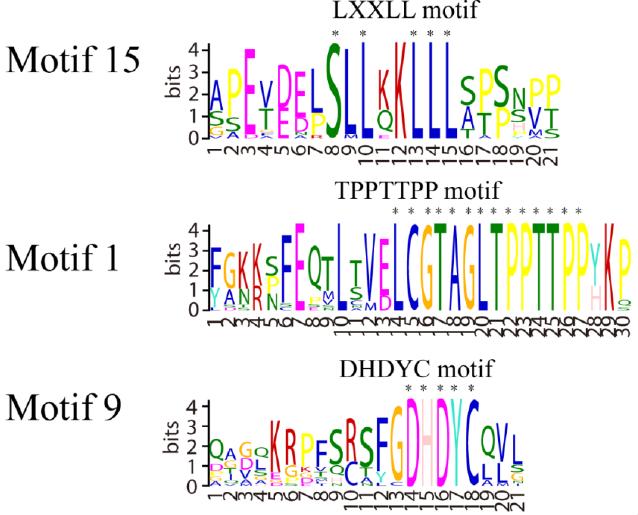
Figure 1. Phylogenetic and MEME analysis of peroxisome proliferator-activated receptor-gamma coactivator-1 β (PGC-1 β ) family proteins between different animals. On the left is the phylogenetic tree of PGC-1 β family proteins in different animals using Bayesian inference (BI), the right panel shows the conserved motif form of PGC-1 β proteins in corresponding animals by MEME software. The topology of the BI tree revealed the evolutionary relationships of PGC-1 β with the precision of topology supported by a high bootstrap value. The composition of conserved motif showed motif loss and rearrangement between fish and mammals.